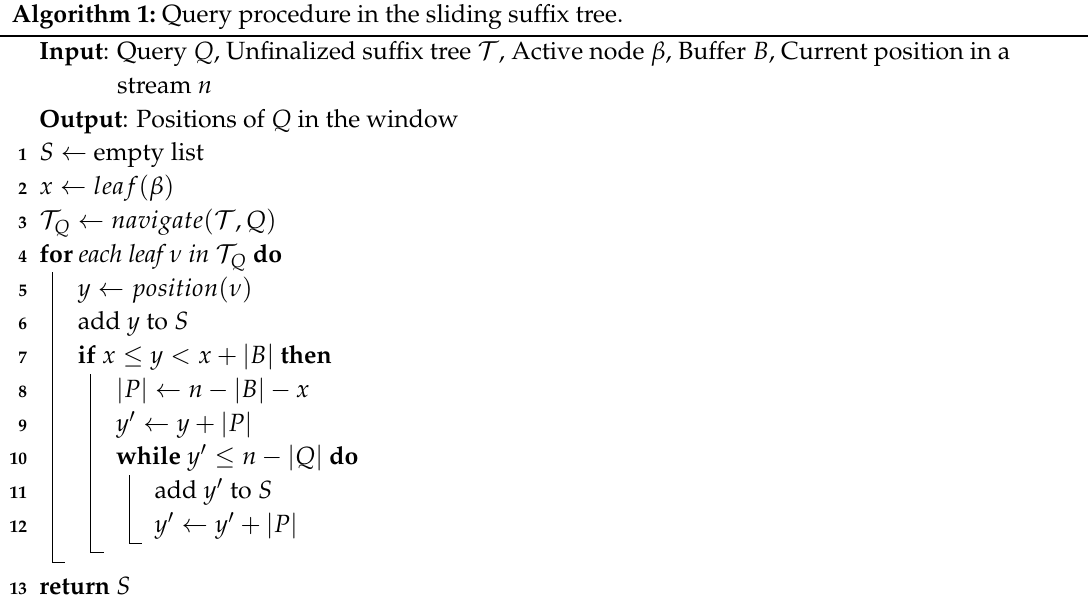
Algorithm 1 combines all three cases presented above in a simplified, clear way. Algorithm 1: Query procedure in the sliding suffix